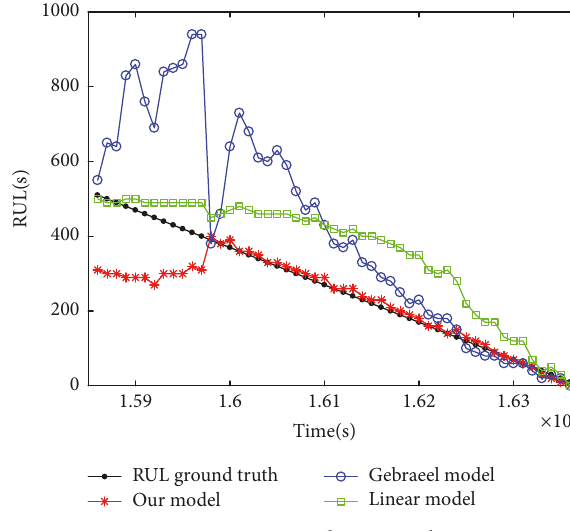
Figure 9: RMS estimated results. Figure 10: RUL prediction results. Table 4: CRA of three models for different